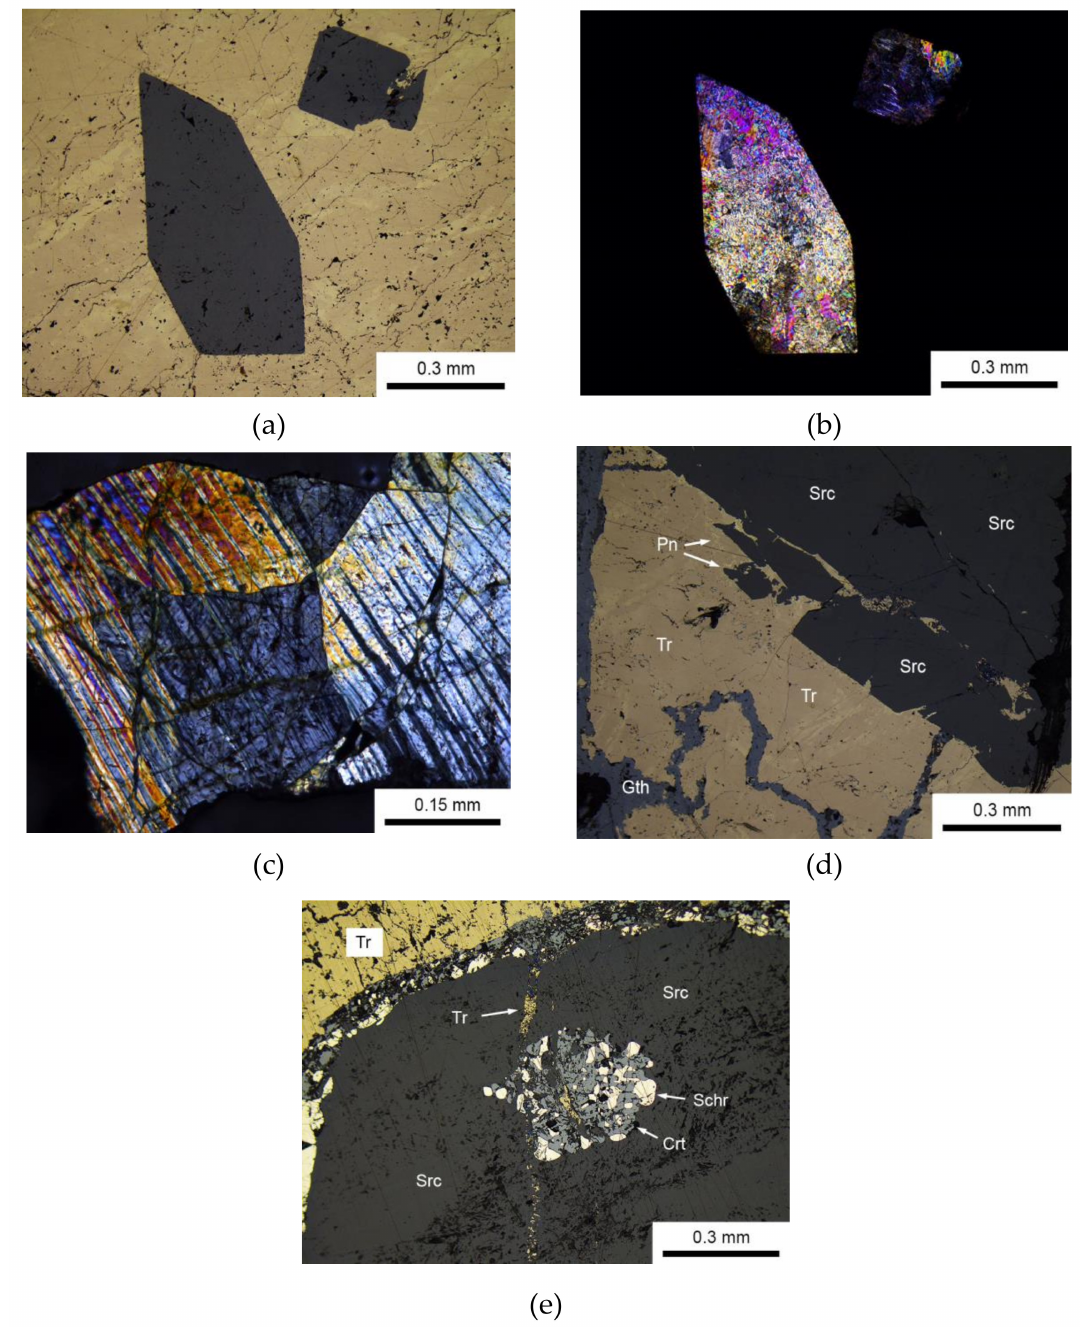
Figure 1. Phosphate-phosphide assemblages of troilite nodules of the Augustinovka meteorite. ( a ) Pseudo-euhedral sarcopside grains (dark-grey) in fine-grained troilite The lenticular structure of host troilite is revealed by color variations in yellow-tan hues. Reflected light, crossed polars. ( b ) The same area in transmitted light under crossed polars. Note the mosaic interior of macroscopically euhedral sarcopside crystals. ( c ) Polysynthetic twinning typical of sarcopside from Augustinovka. Transmitted light, crossed polars. ( d ) Brecciated sarcopside grain surrounded by pentlandite veinlets in partially altered troilite. Reflected light, crossed polars. I Sarcopside grain penetrated by the troilite veinlet, enveloped in and hosting fine-grained chromite-schreibersite aggregates. Reflected light, parallel polars. Abbreviations: Src, sarcopside; Tr, troilite; Pn, pentlandite; Schr, schreibersite; Crt, chromite; Gth, goethite (weathering product). Photomicrographs by Sergey